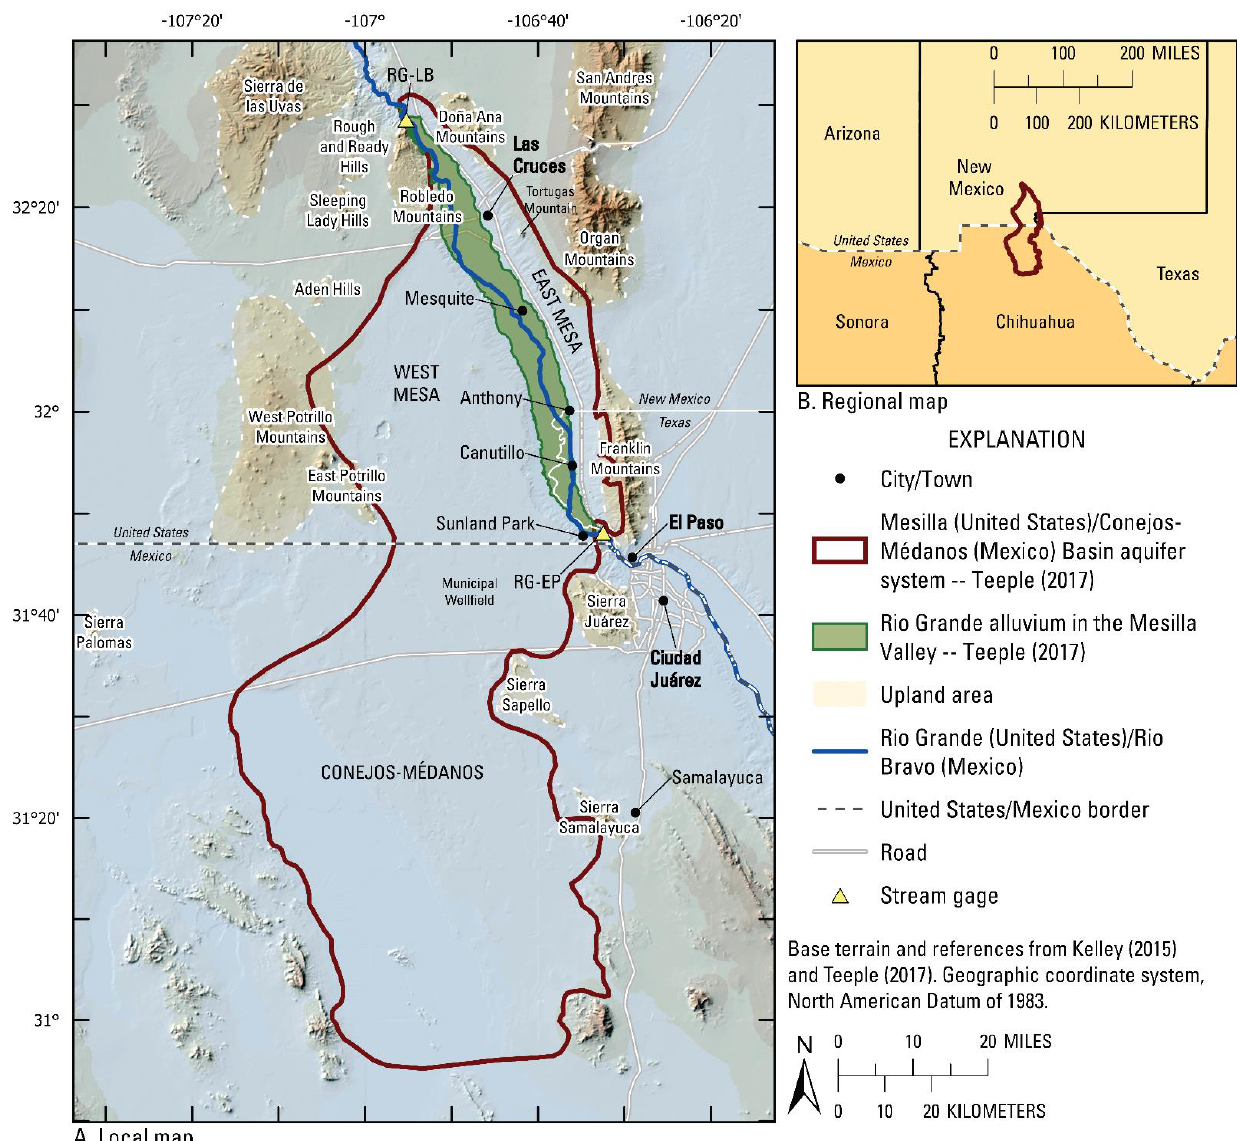
Figure 1. Local ( A ) and regional ( B ) maps showing the location of the study area in the United States (New Mexico and Texas) and Mexico (Chihuahua) [21,22]. All analyzed temperature data in this work were collected in the United States, while interpreted groundwater elevation mapping covers substantial portions of the aquifer system in both countries. Stream gage abbreviations are as follows: RG-LB = USGS 08363510 Rio Grande below Leasburg Dam at Fort Selden, New Mexico; RG-EP = USGS 08364000 Rio Grande at El Paso, Texas